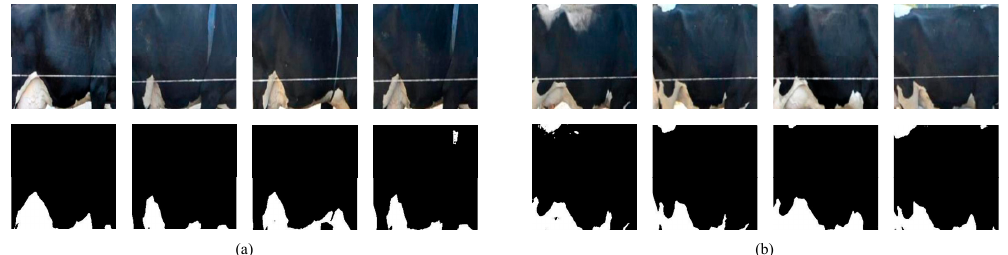
Figure 11. Body pattern images of two cows with the lowest identification rate.